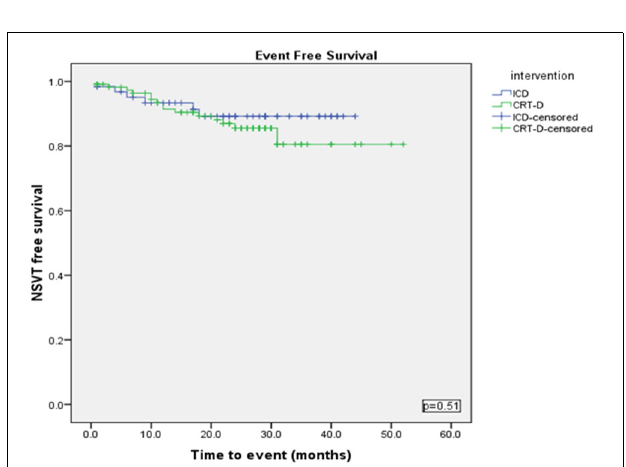
FIGURE 4 | Kaplan Meyer survival analysis of the occurrence of NSVT between ICD and CRT-D groups.